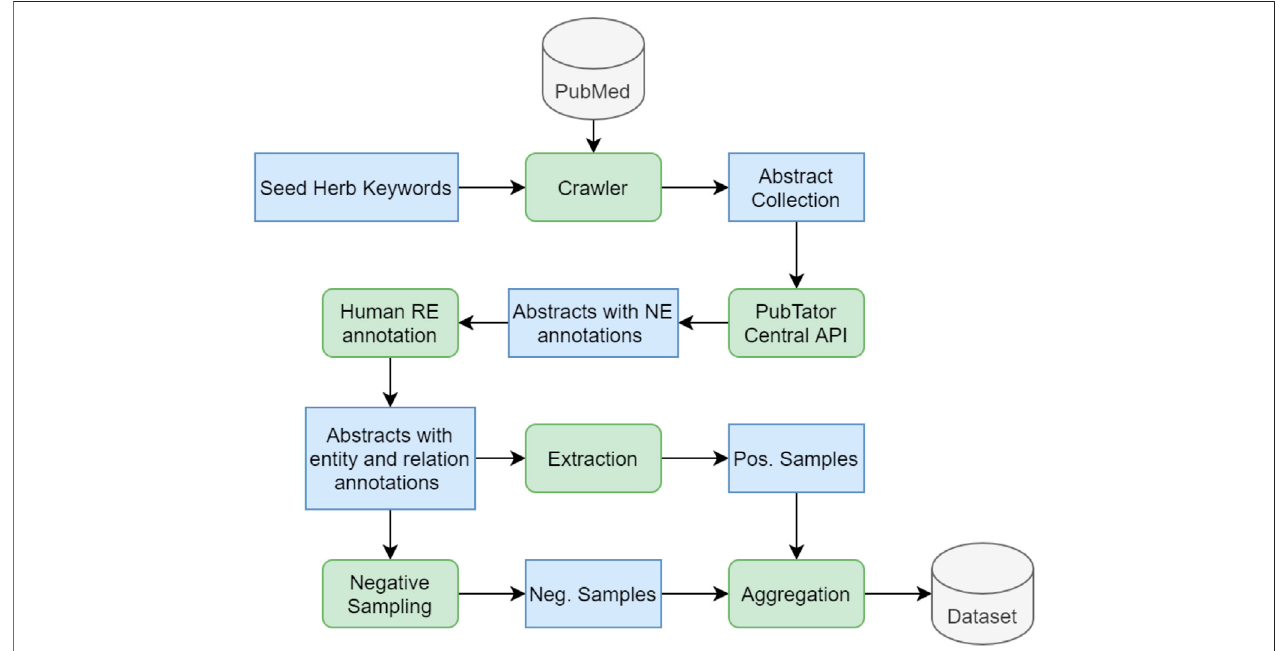
FIGURE 4 | The development process of the Herb RE dataset. A crawler is adopted to search for a pre-de fi ned set of herb keywords in the PubMed dataset, returning a collection of matching abstracts that are fi rstly annotated by the PTC for NER and then annotated by a human annotator for RE. Thereafter the positive examples can be directly extracted, and the negative examples can be obtained through negative sampling. The positive and negative samples are aggregated to form the fi nal herb RE dataset. Blue boxes in the fi gure represent various types of data being processed along the pipeline, and green rounded boxes represent operations/functions applied on the data.